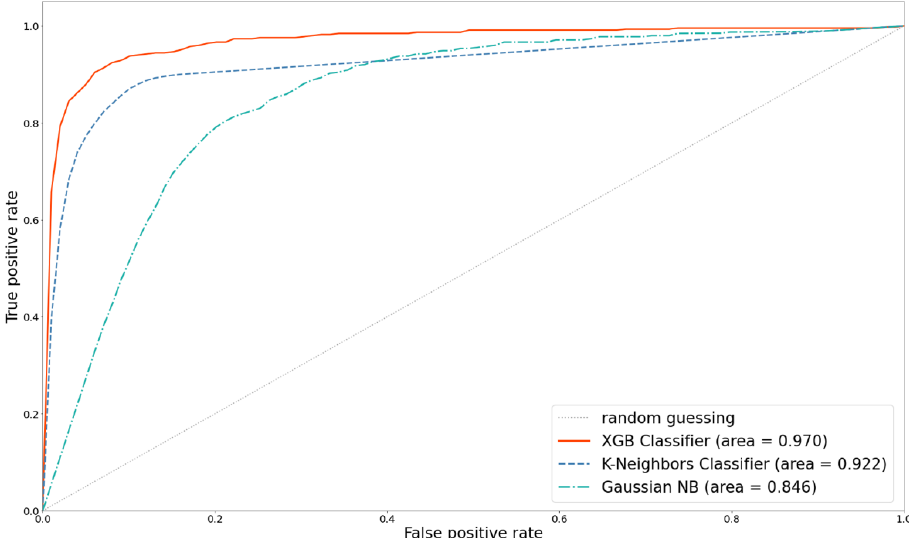
Figure 12. Comparison of ROC curves with different classifiers.